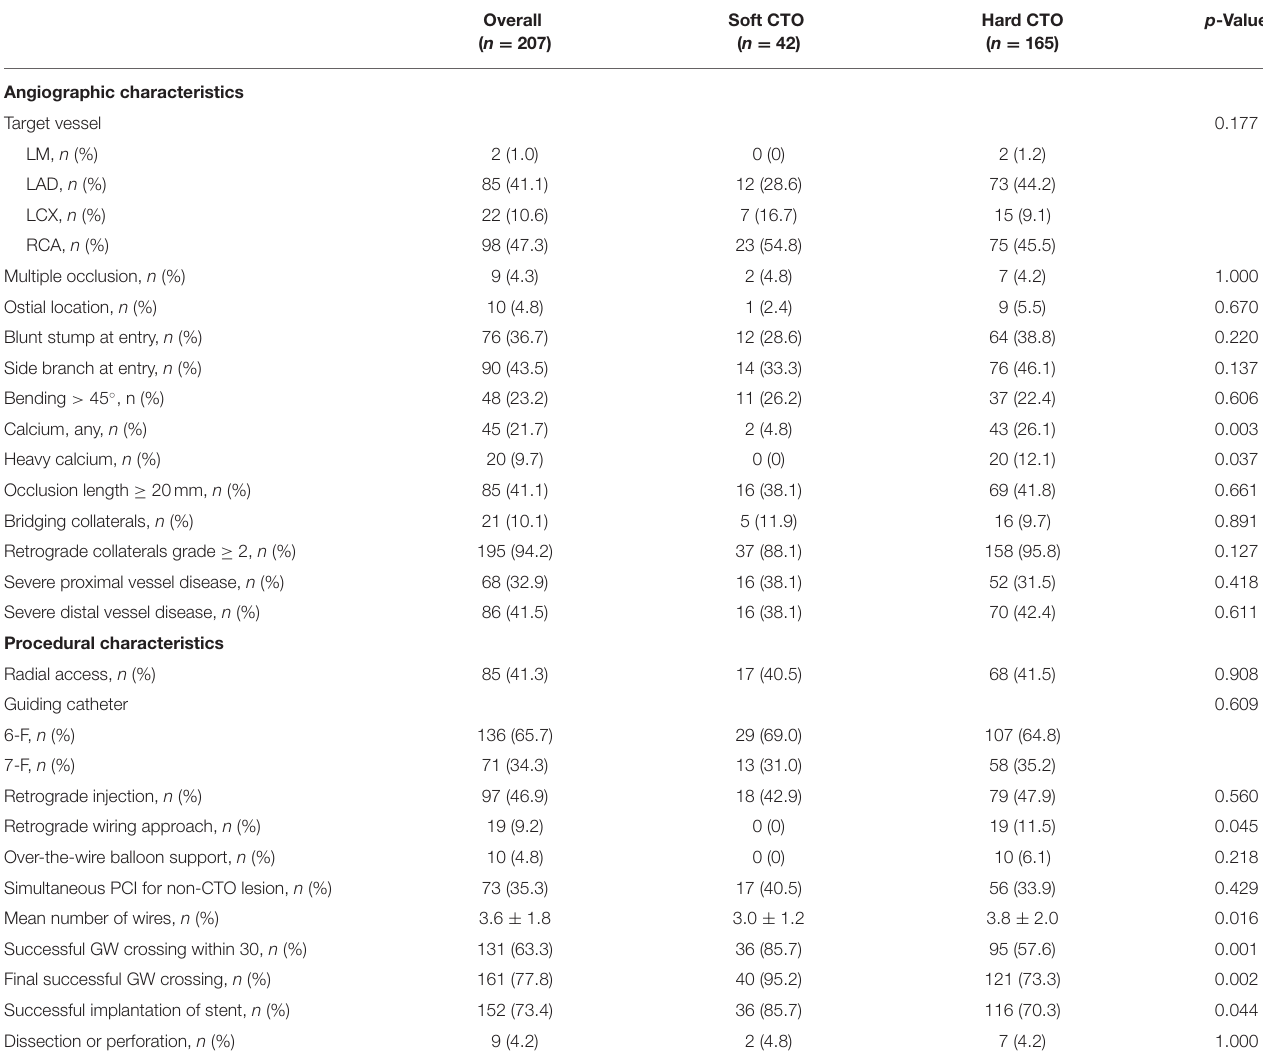
TABLE 2 | Angiographic and procedural characteristics.